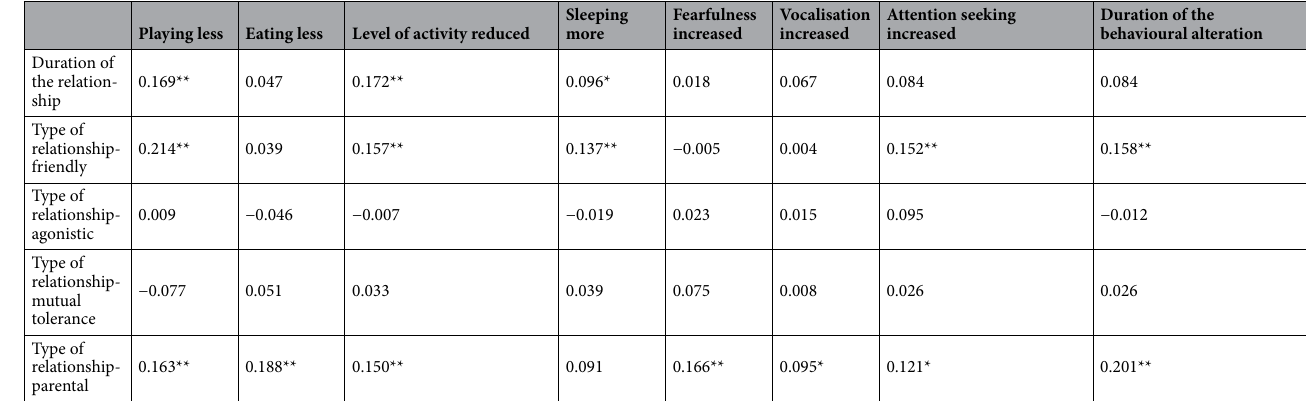
Level of activity reduced